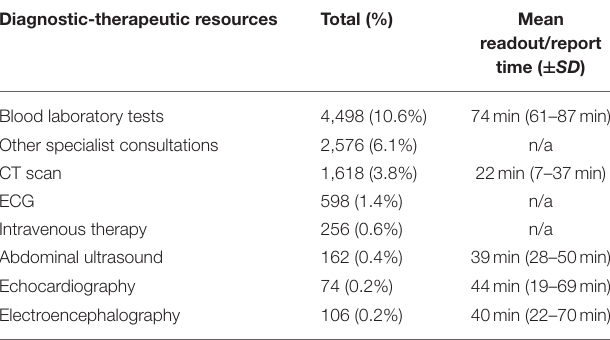
TABLE 2 | Diagnostic-therapeutic resources used for children accessing to the Emergency Department (2014–2019) and mean readout/report time from physical examination (when applicable).